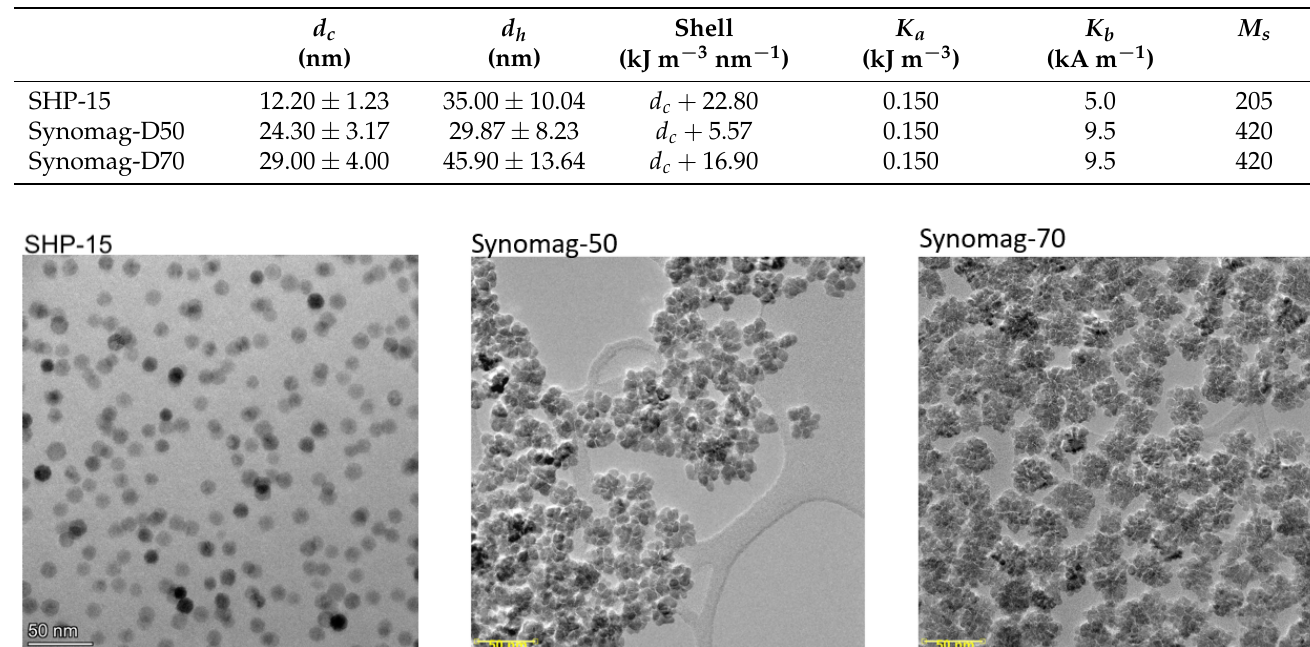
Table 1. MNP parameters: d c : core diameter; d h : hydrodynamic diameter; K a and K b : anisotropy constants based upon Equation (13) [32]; and M s : saturation magnetisation [33,34].